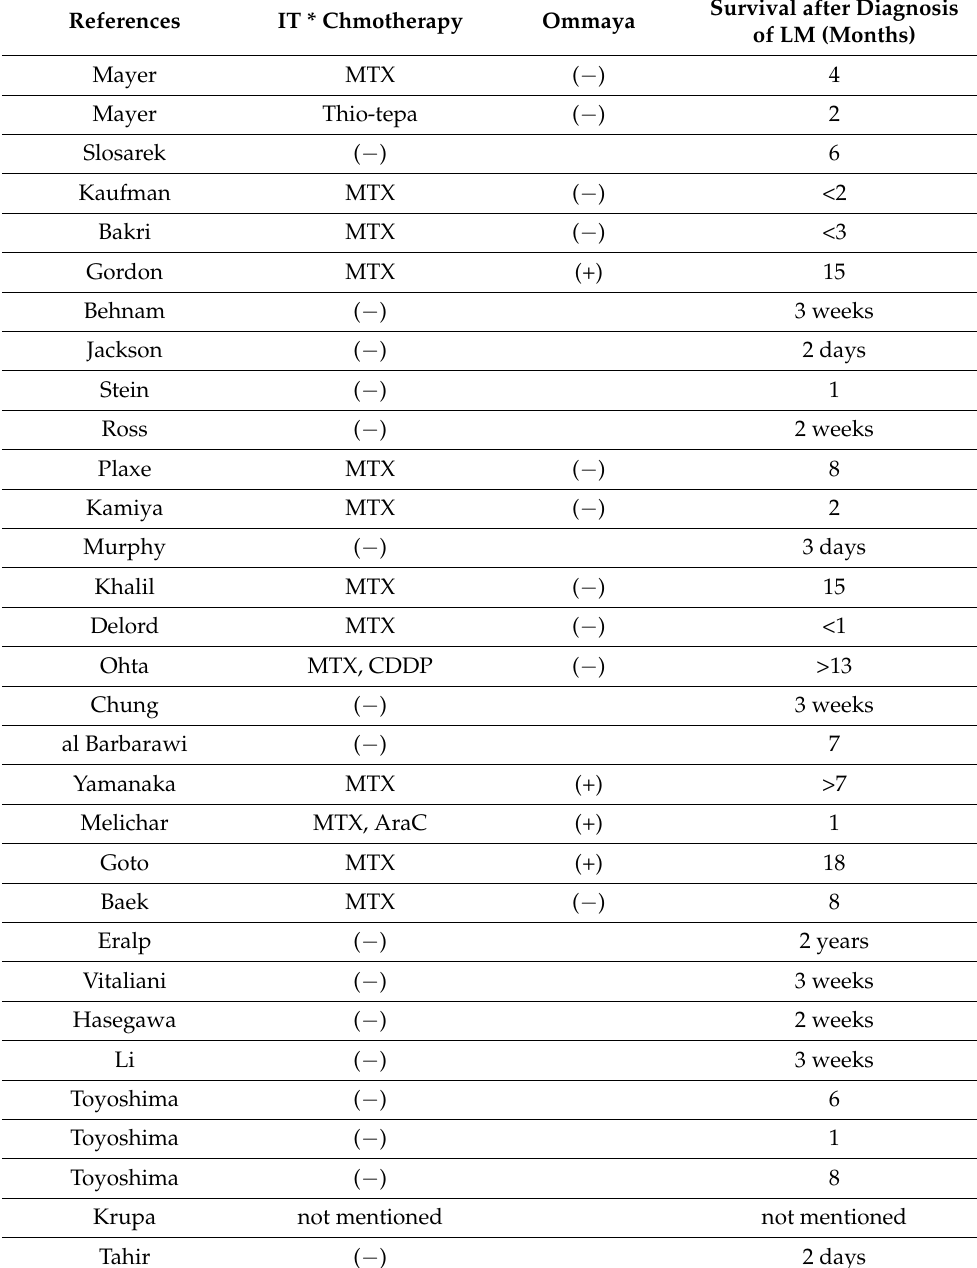
Table 1. Reported cases of patients with LMC from ovarian